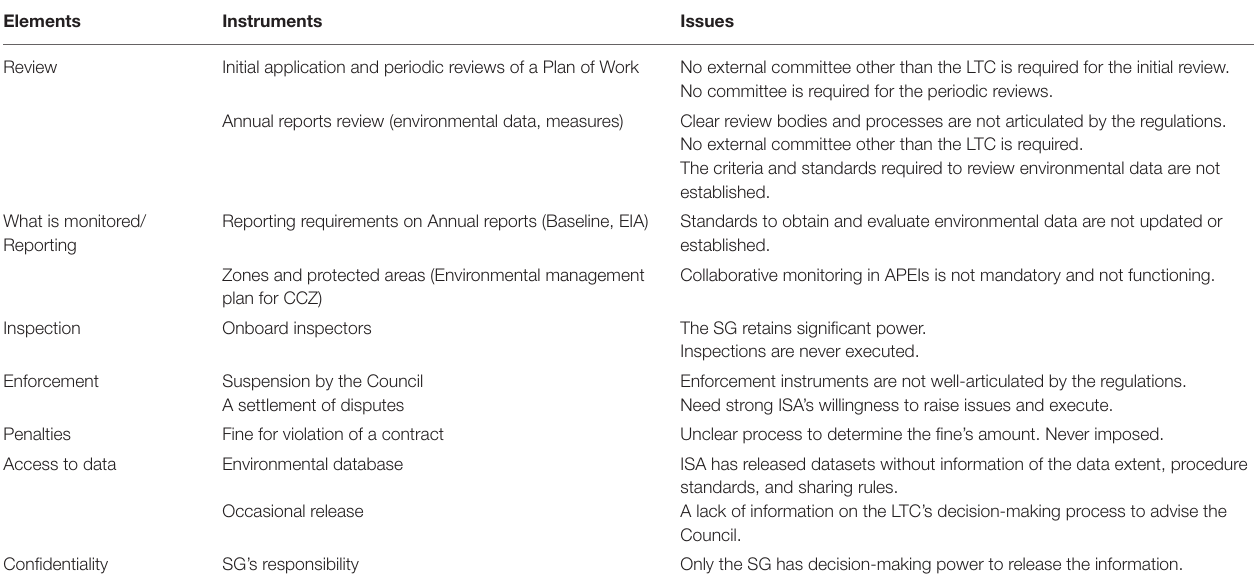
TABLE 2 | Potential issues of the ISA monitoring system for